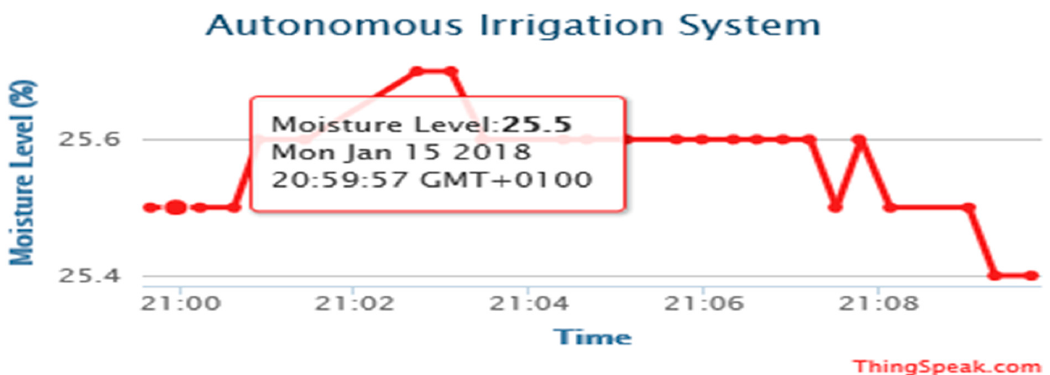
Figure 16. Moisture levels against time obtained from http://www.thingspeak.com (API key = FE4H530DNA2NJQXB).